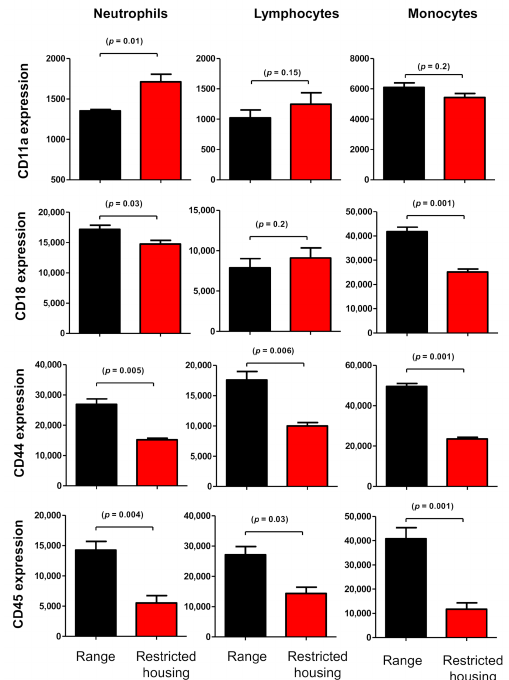
Figure 6. Flow cytometric assessment of the abundances of the adhesion molecules CD11a, CD18, CD44, and CD45 on the surfaces of leukocytes. Leukocytes were labeled with monoclonal antibodies against CD11a, CD18, CD44, and CD45, and labeled cells were analyzed by flow cytometry. After gating on camel neutrophils, lymphocytes, or monocytes, the expression levels of CD11a, CD18, CD44, and CD45 were measured as MFI of analyzed markers, and the results are presented as mean ± SEM ( t